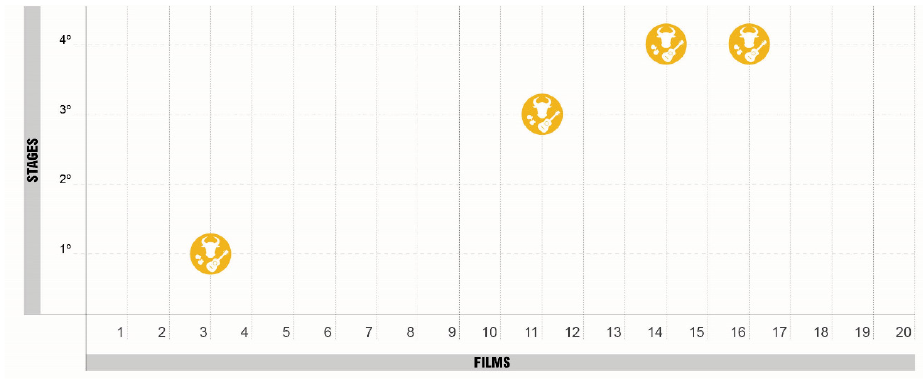
Figure 4. Socio-cultural imaginary indicator (identity): most representative films (source: created by